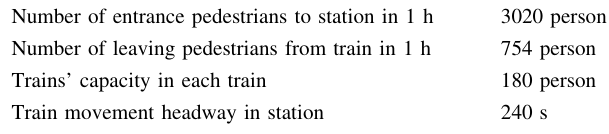
Table 6 Scenario 2 inputs Number of entrance pedestrians to station in 1 h 3020 person Number of leaving pedestrians from train in 1 h 754